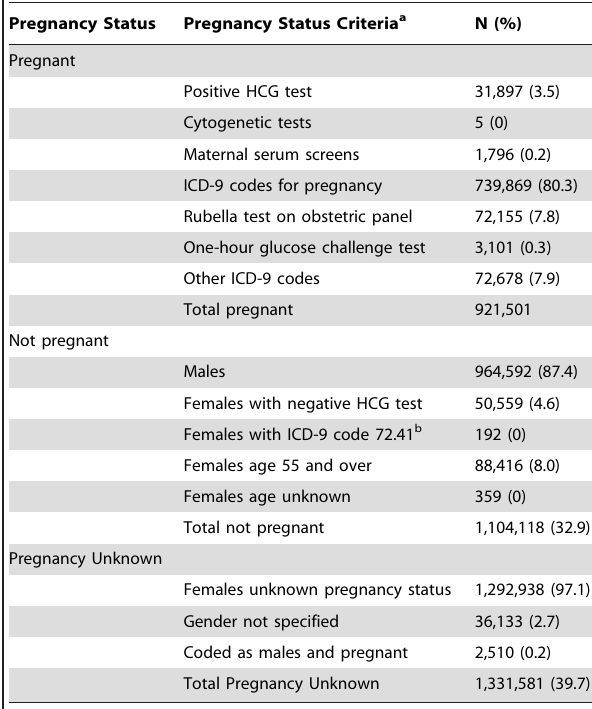
Table 1. Pregnancy status of persons with specimens tested at a national commercial laboratory using Genetic